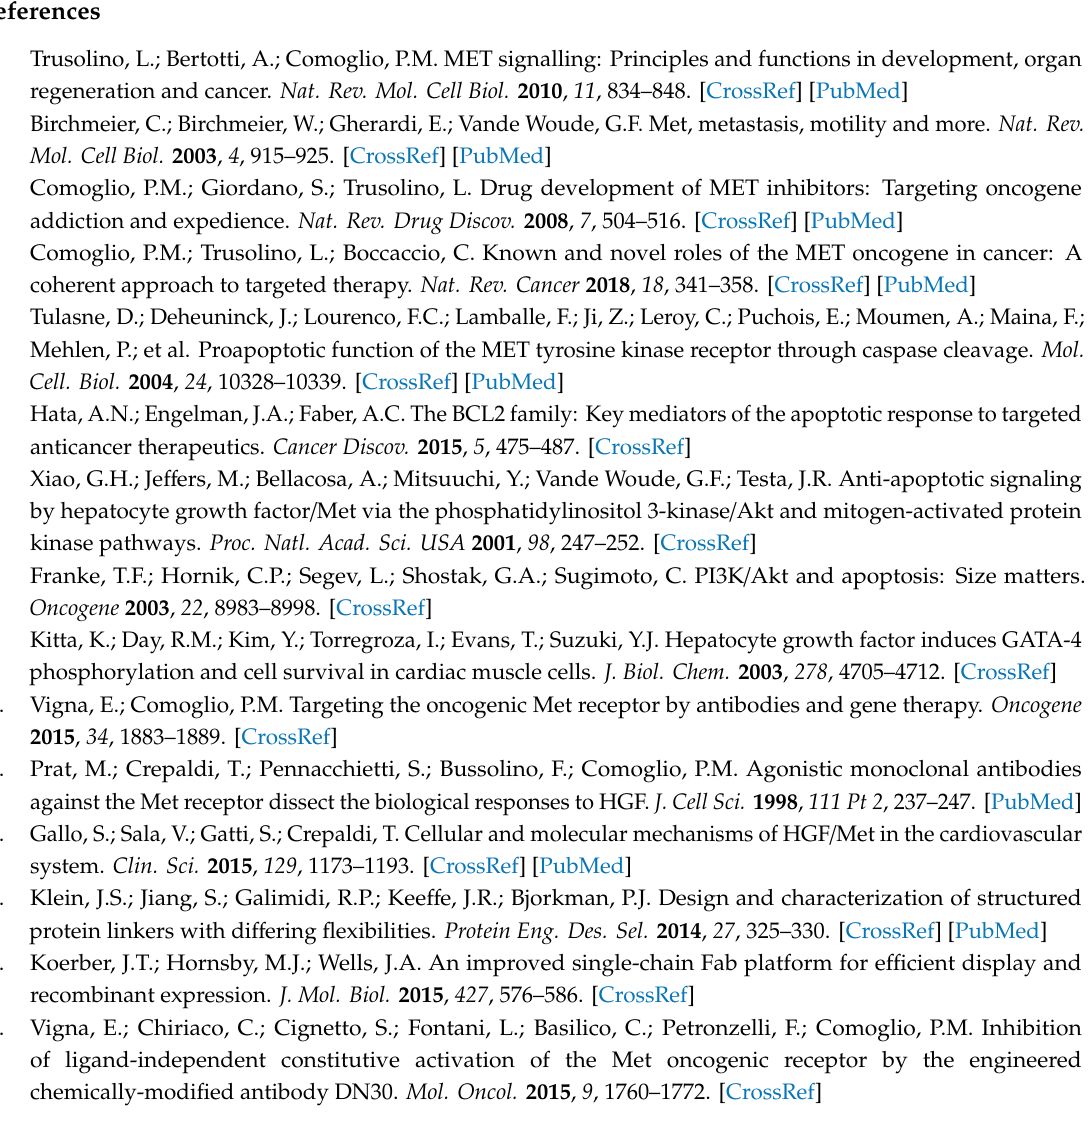
Figure S1: Short-sc25 induces MET activation, Figure S2: Activity of short-sc25 in combination with HGF, Figure S3: Short-sc25 induces scattering of A549 cells, Figure S4: Short-sc25 inhibits caspase-3 activation in H9C2 cells treated with doxorubicin, Figure S5: Short-sc25 protects A549 cells from doxorubicin-induced